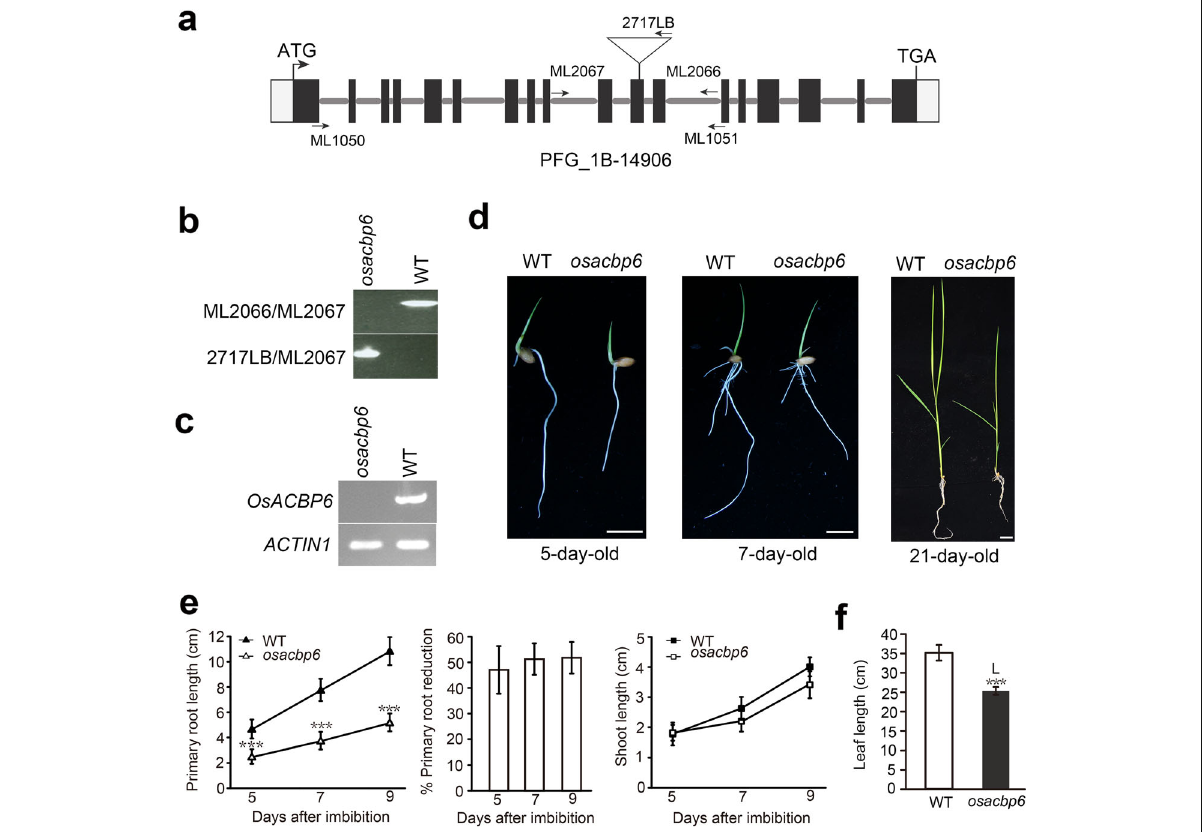
Fig. 1 Characterization of the rice osacbp6 mutant. a T-DNA insertion in OsACBP6 , and primer locations used for PCR genotyping. Black and grey boxes indicate coding and untranslated regions, respectively. b PCR genotyping of osacbp6 . Primer combinations ML2066/ML2067 (top gel) and 2717LB/ML2067 (bottom gel) in PCR to identify osacbp6 homozygous mutant. c Semi-quantitative RT-PCR showing the knockout of OsACBP6 in osacbp6 . ACTIN1 served as a control. d Growth of wild type (WT, Oryza sativa var. japonica cv. Dongjin) and osacbp6 . Images from left to right represent 5-, 7-day-old seedlings grown in water, and 21-day-old soil-grown seedling. Bars, 1 cm. e The primary root length (left) and shoot length (right) comparison between WT and osacbp6 . Primary root reduction of osacbp6 is shown in the middle. Values are mean ± SD ( n = 25). f Comparison of the leaf length of 21-day-old soil-grown seedlings between WT and osacbp6 . Values are mean ± SD ( n = 5). Asterisks indicate significant differences between WT and osacbp6 as evaluated by Student ’ s t -tests: *** P <